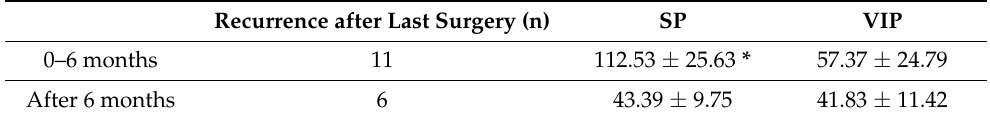
Table 3. SP and VIP values in relation to time between last two recurrences * p = 0.0134 compared to the group that recurred after 6 months. ‘n’ denotes number of patients.